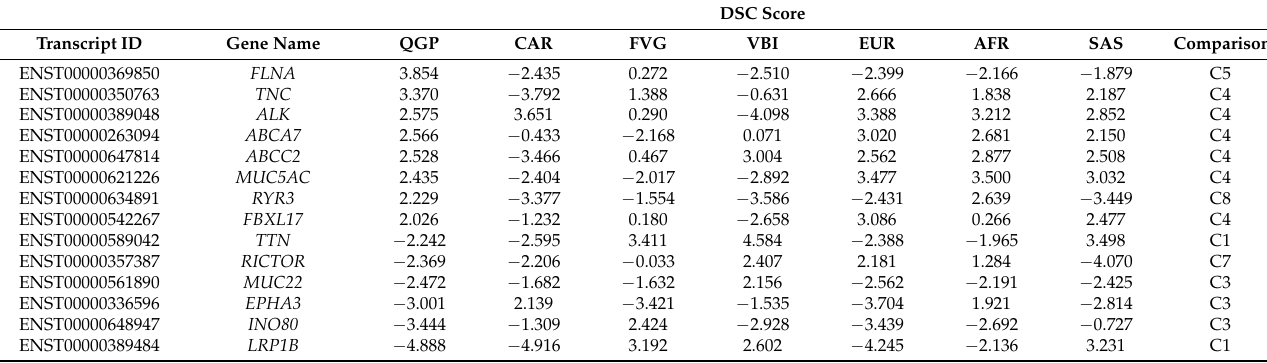
Table 1. Results from comparison of DSC scores between target cohorts (CAR, FVG, VBI, QGP) and the relevant reference superpopulations from the 1000 Genomes Project (EUR, AFR, SAS). The last column refers to the nature of the comparison carried out, as detailed in Supplementary Table S3.